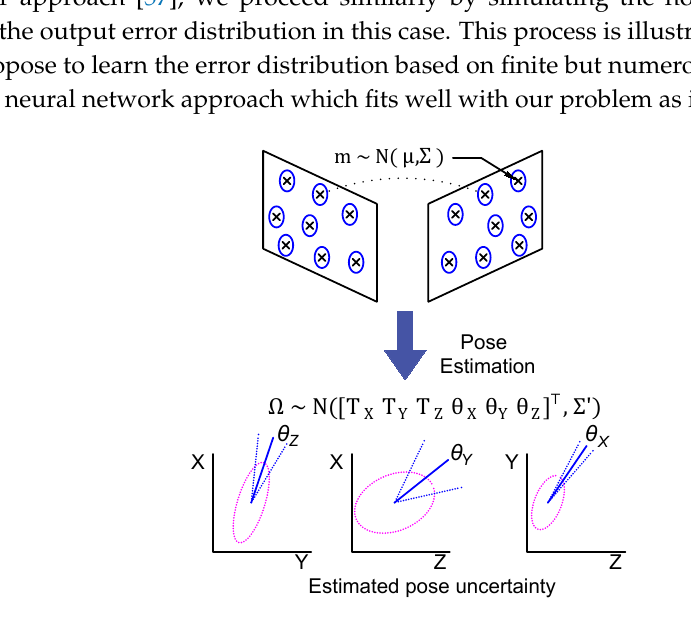
Figure 11. Illustration of error propagation through the pose estimation procedure. The estimated pose uncertainty is shown for each of the six DOF. A full error covariance matrix could result from uncorrelated error distribution of matched 2D feature